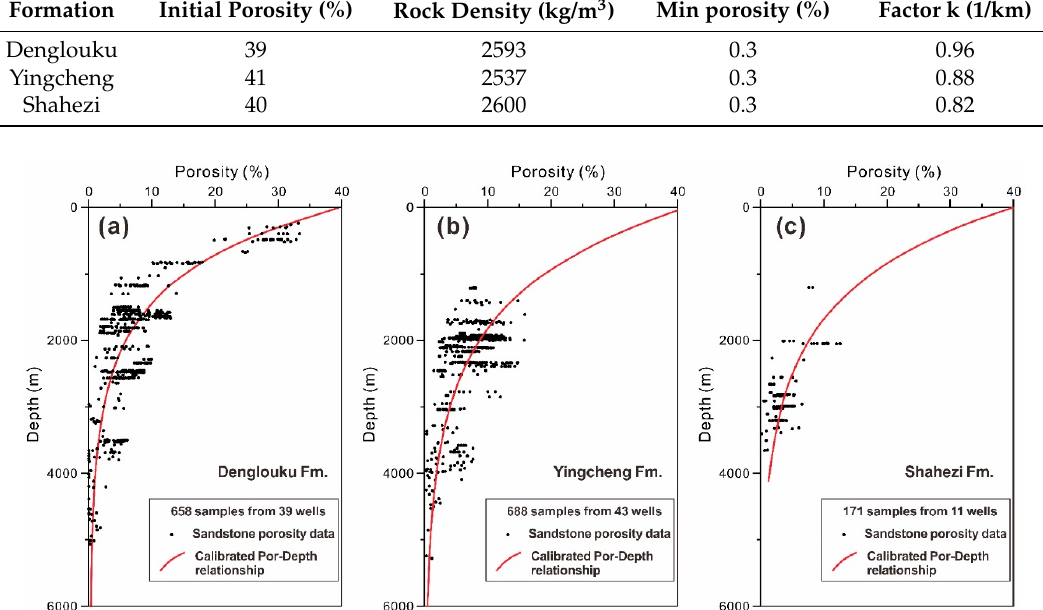
Table 3. Parameters that were used in Athy’s law to calibrate the porosity versus depth curve. Formation